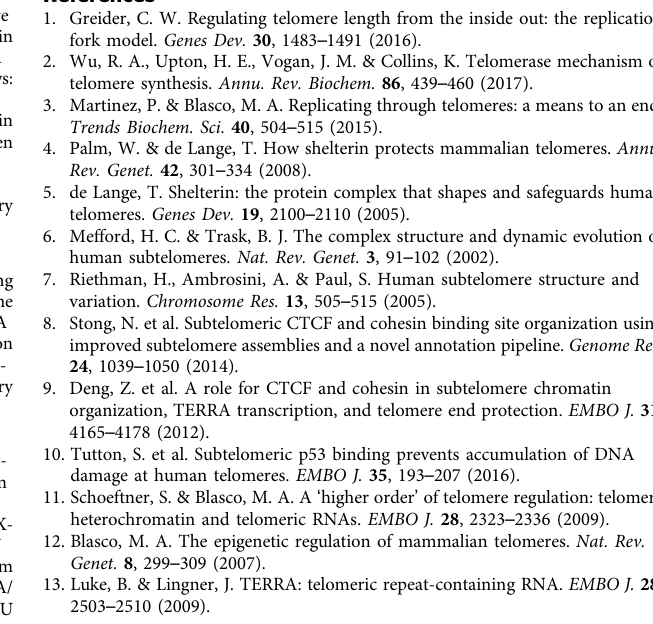
Fig. 1a. RT-qPCR and RNA DotBlot . RNA was isolated using Trizol (Invitrogen) following manufacture's instructions. An aliquot of 5 μ g of RNA was blotted onto membrane for dot blots 9 . RNA was DNase treated and converted to random primed cDNA using Superscript III kit (Invitrogen). cDNA was assessed for TERRA transcription levels, using GAPDH as control. Primers for qPCR analysis are listed in Supple- mentary Table 2 and locations of 17p primers are shown visually in Supplementary Fig. 1a. Brdu immunoprecipitation . Genomic DNA was collected from cells after incor- poration of BrdU. DNA isolation kit (Promega). DNA was sonicated to between 100 – 500 bp in length. Sonicated DNA was denatured for 5min at 100 C and diluted in IP buffer (10 mM Sodium Phosphate pH7, 0.14M NaCl, 0.05% Triton X- 100). BrdU containing DNA was immunoprecipitated with 2 – 4 µ g of anti-BrdU antibody (BD Pharmingin mouse-anti BrdU Clone 44 (#347850)) for 1h at room temperature and collected using protein G agarose beads for 30 min. Isolated DNA/ immune complexes were washed 4 times with IP buffer and dissociated using